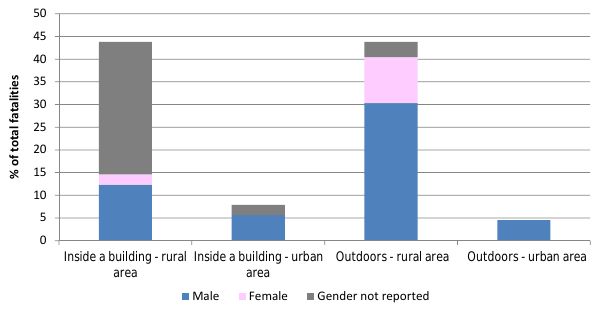
Figure 8. Circumstances surrounding the fatalities by gender during the December 1909 event in